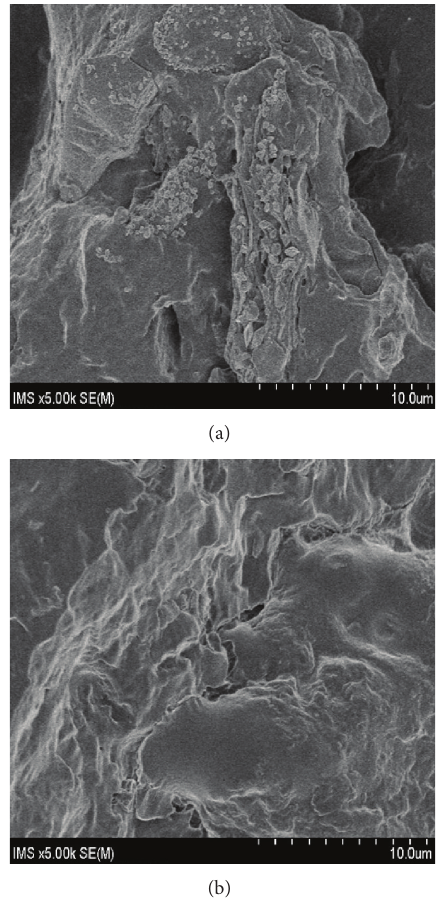
Figure 3: Surface of untreated RHF (a) and NaOH-treated RHF (b).